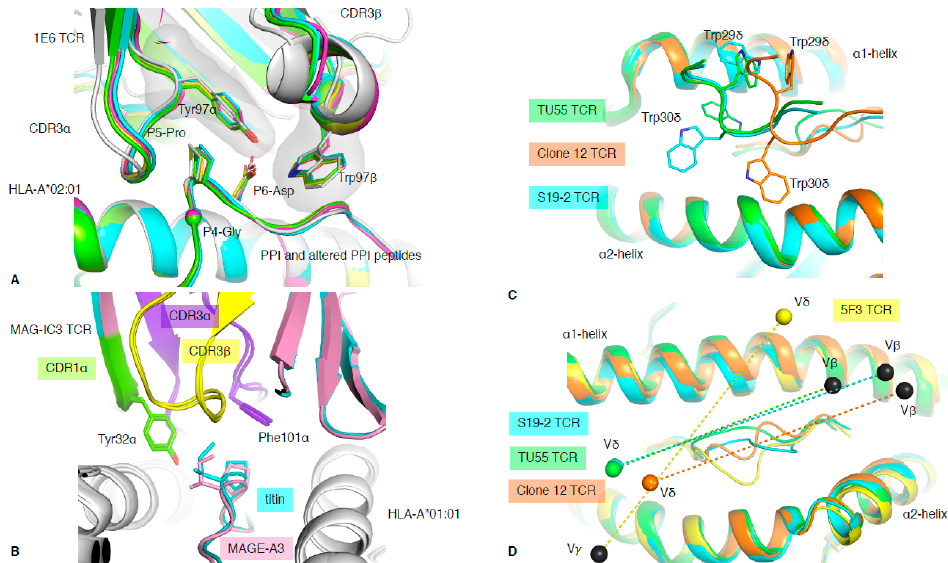
Figure 5. TCR cross-reactivity and non- αβ TCR recognition. ( A ) Structural overlay of the 1E6 TCR in complex with the PPI (white) and altered PPI peptides: YQF (green), RQW (orange), MVW (cyan), RQF-I (pink), and RQF-A (yellow). The conserved 4 GPD 6 motif in the peptide is represented as sticks and spheres for the C α atom of the P4-Gly. The CDR3 loop residue Tyr97 α and Trp97 β forming the hydrophobic cap are represented as sticks. ( B ) Structural overlay of the MAG-IC3 TCR in complex with the HLA-A*01:01 (white) presenting the MAGE-A3 (pink) or titin (cyan) peptide. The TCR is coloured as per the bound peptide, with the CDR1 α in green, CDR3 α in purple, and CDR3 β in yellow. ( C ) Top view of structural overlay of δβ TCRs in complex with pHLA-I complex. The TU55 TCR-HLA-B*35:01-IPL is in green, S19-2 TCR-HLA-A24:02-RYP is in cyan, and clone 12 TCR-HLA-B*35:01-IPS is in orange. The conserved TRDV1*01 CDR1 δ is represented as a loop with the Trp29 δ and Trp30 δ represented as sticks. ( D ) As per panel ( C ), the top view of the MHC-I cleft with a structural overlay of three δβ TCRs–pMHC-I complex and the 5F3 γδ TCR added (yellow). The mass centres for the V β or V γ are represented as black spheres, while the V δ mass centres are presented as coloured spheres matching each TCR as per panels ( C , D ). All the structural overlays are aligned on the MHC-I cleft (residues